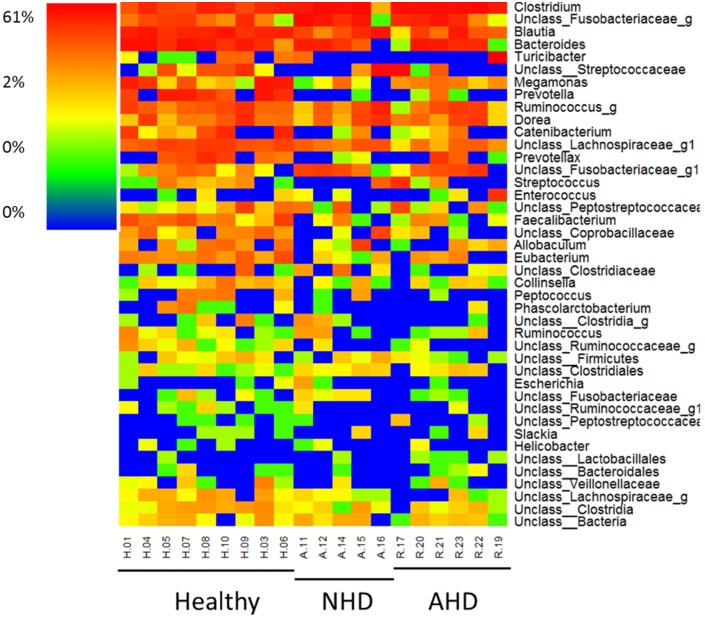
Heatmap illustrating the relative abundance of predominant bacterial genera in fecal samples.Healthy = healthy dogs; NHD = acute non-hemorrhagic diarrhea; AHD = acute hemorrhagic diarrhea. “Unclass.” denotes an unclassified genus within the respective taxa.